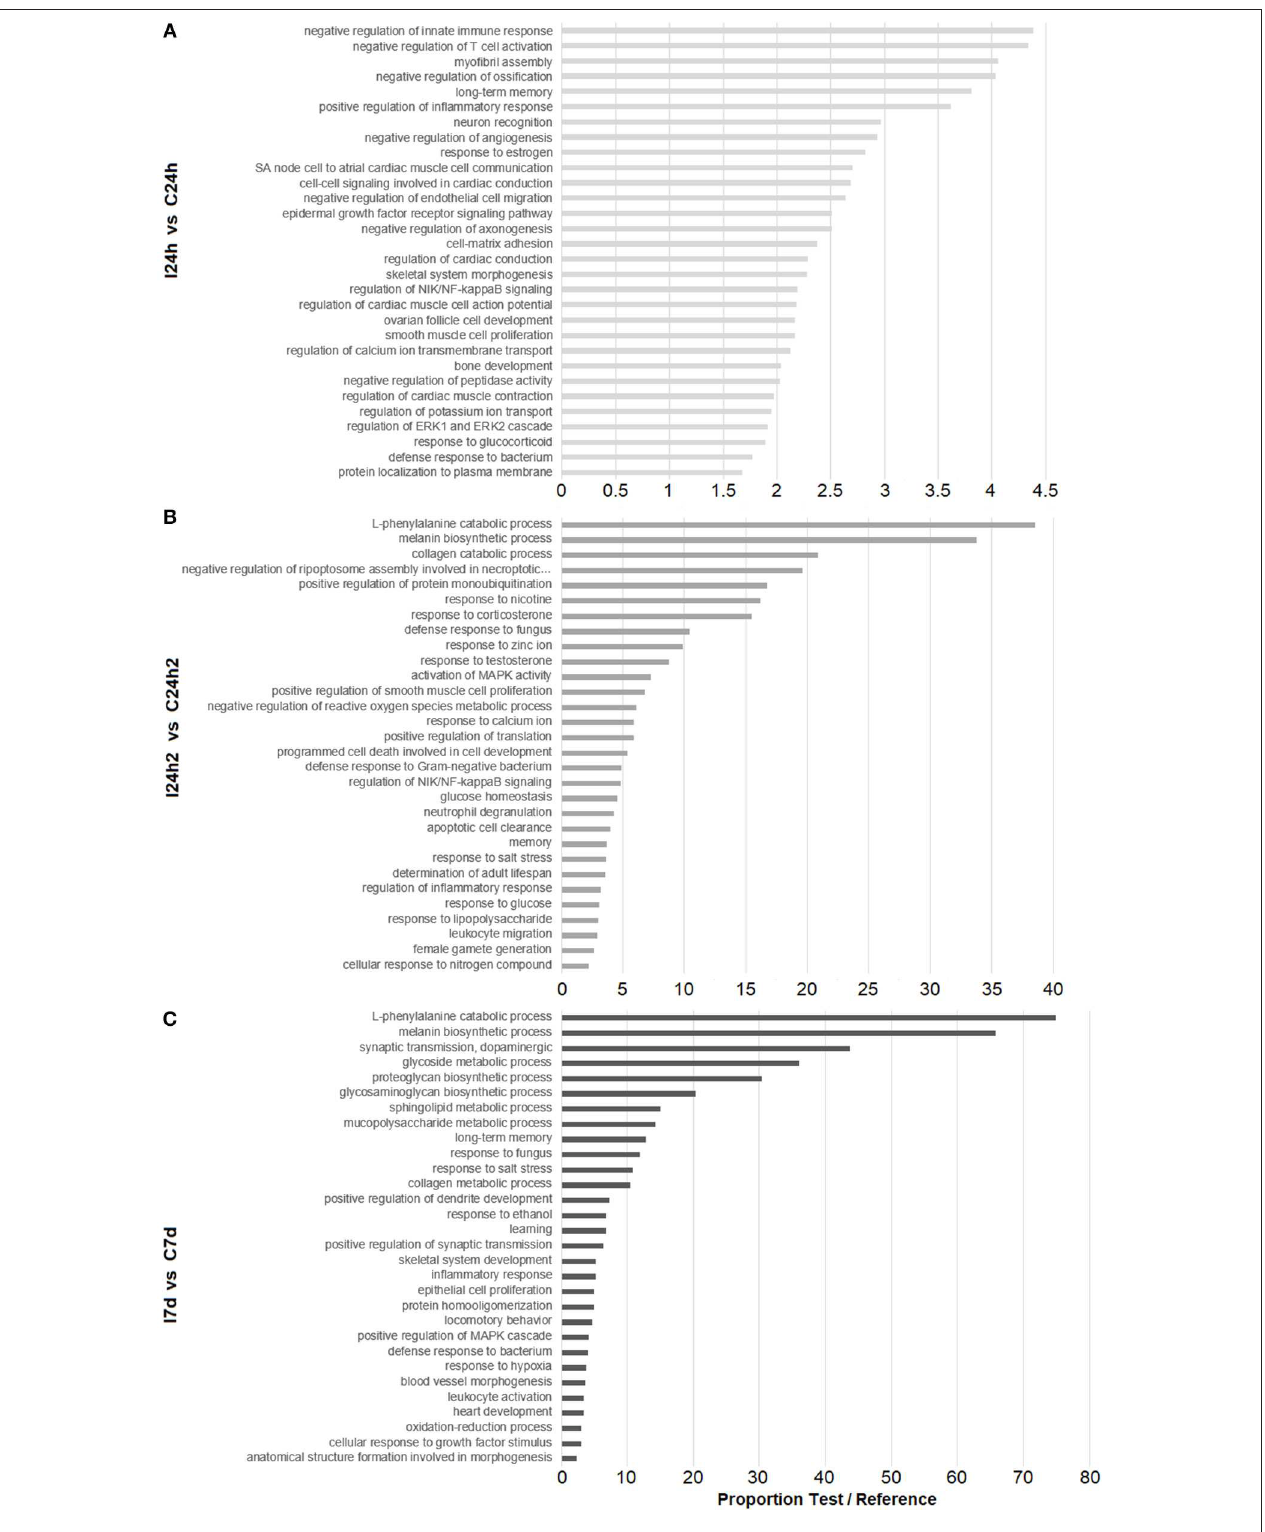
FIGURE 3 | Enrichment analysis of DEGs according to the experimental design. Bars represent the proportions between the percentages of sequences in the test set (our DEGs list) and the reference set (transcriptome). (A) Biological processes overrepresented in infected mussels 24 h after the first infection. (B) Biological processes overrepresented 24 h after the second infection. (C) Biological processes overrepresented 7 d after the second infection.